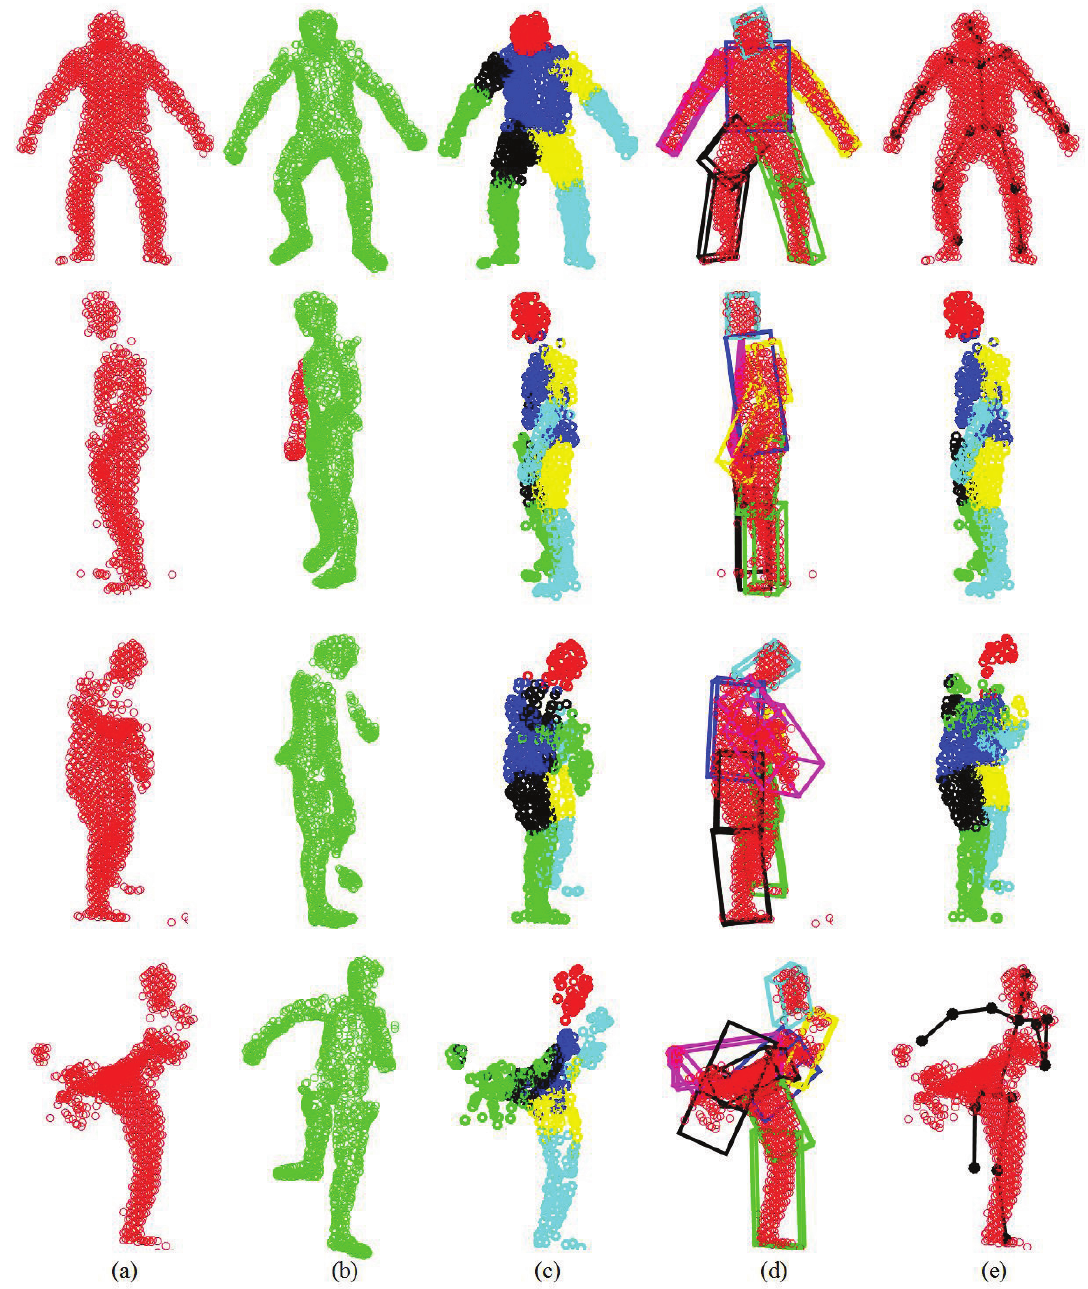
Figure 19. Validation and re-initialization results for a passing case (first row) and three failed cases (second to fourth row). Columns ( a – e ) are the point set in the current frame, that in the previous frame, correspondence estimation results by GLTP (with body segment labels), segment volume validation and pose estimation/re-initialization results,